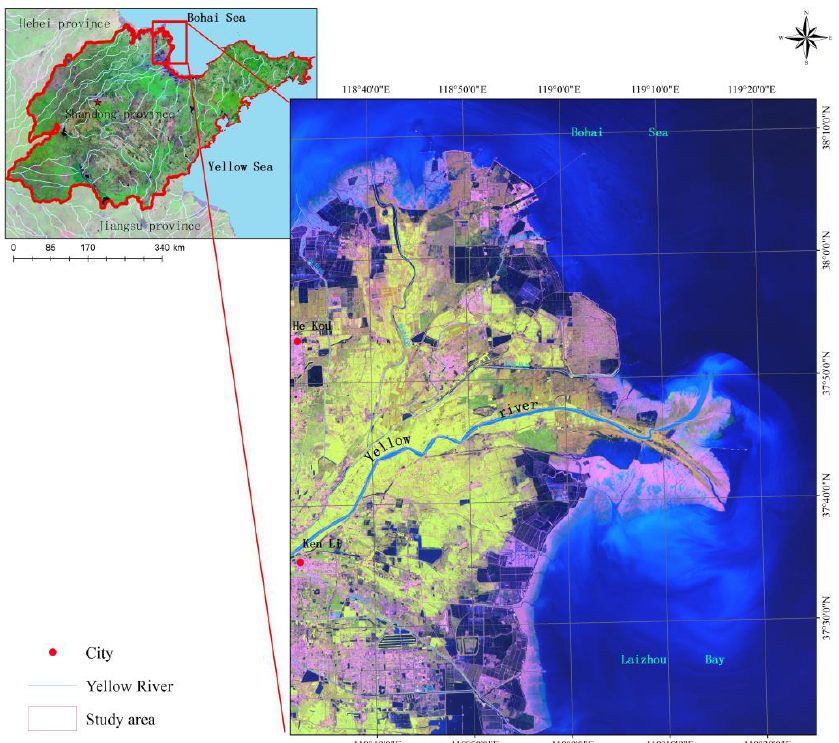
Figure 1. Location of study area.